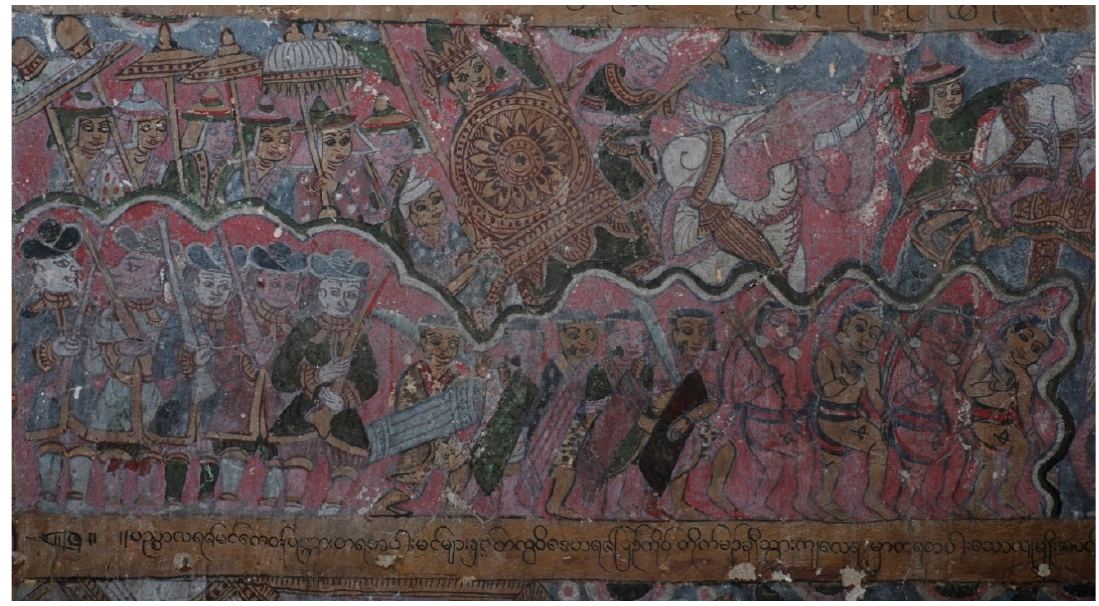
Figure 48. Laung U Maw, Ywathitkye. Early 19th century. Segment of the 101 Tribes, incorporated in the Mahosadha J ā taka.